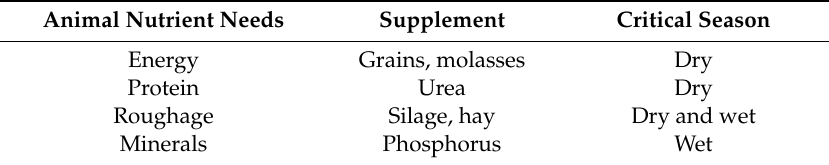
Table 1. Typical tropical animal supplements for critical seasons